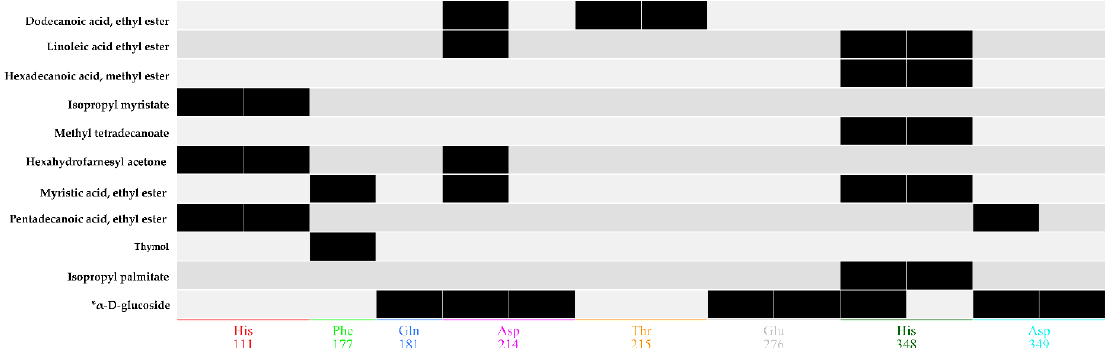
Figure 10. Barcode representation of the final 10 compounds with the reference substrate α -D-glucose, interacting with the alpha-glucosidase active site residues. Each black barcode represents the hydrogen bond interaction of the compounds in y -axis with the active side residue in the x -axis. * Reference substrate ( α -D-glucose) of the alpha-glucosidase protein interaction with active site residues.